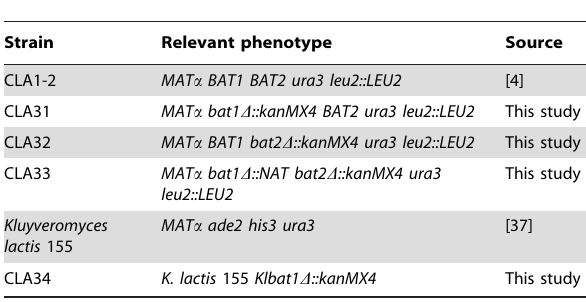
Table 4. Strains used in this